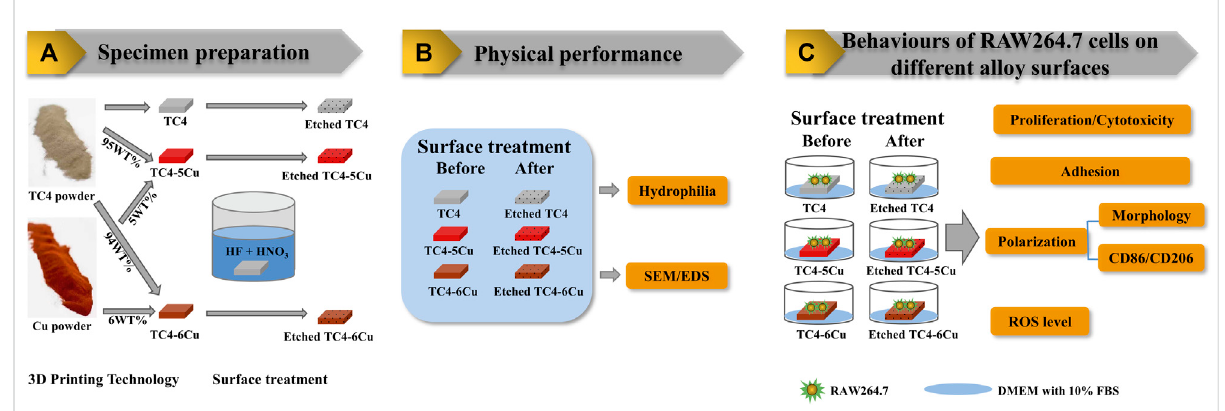
FIGURE 1 Flow diagram of the study: (A) Specimen preparation; (B) Physical performance; (C) Behaviours of RAW264.7 cells on different alloy